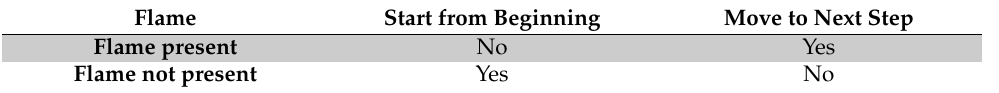
Table 5. Rules for flame